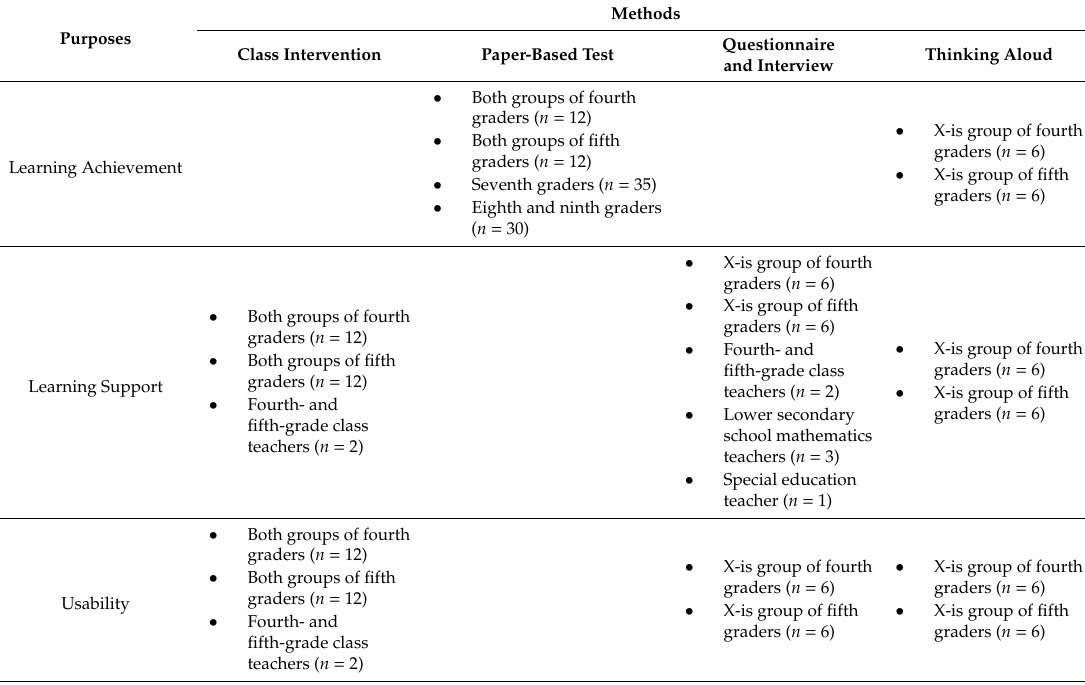
Table 1. Purposes and research design of the classroom